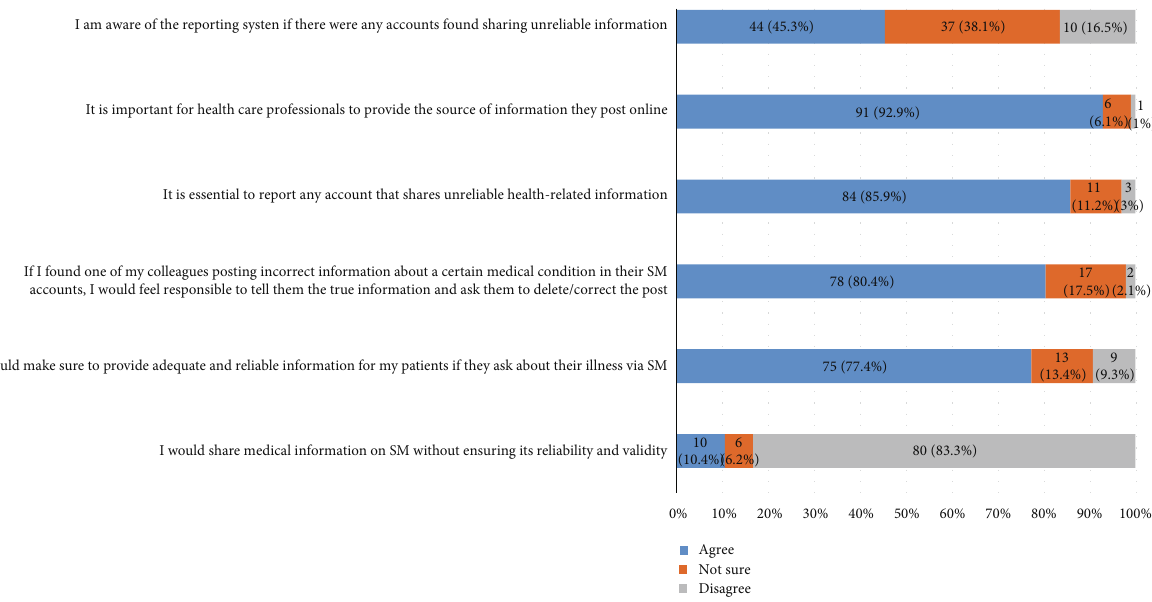
Figure 2: Ethical aspects regarding the reliability of information (social media (SM) and health apps).